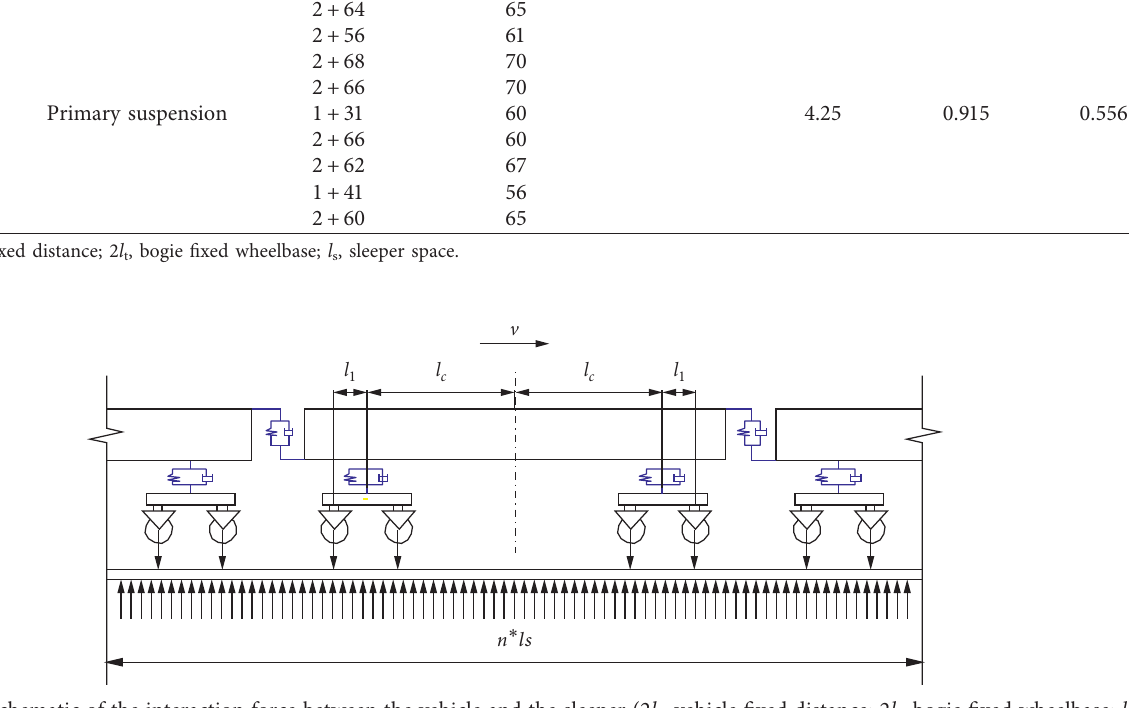
c , vehicle fixed distance; 2 l t , bogie fixed wheelbase; l s ,